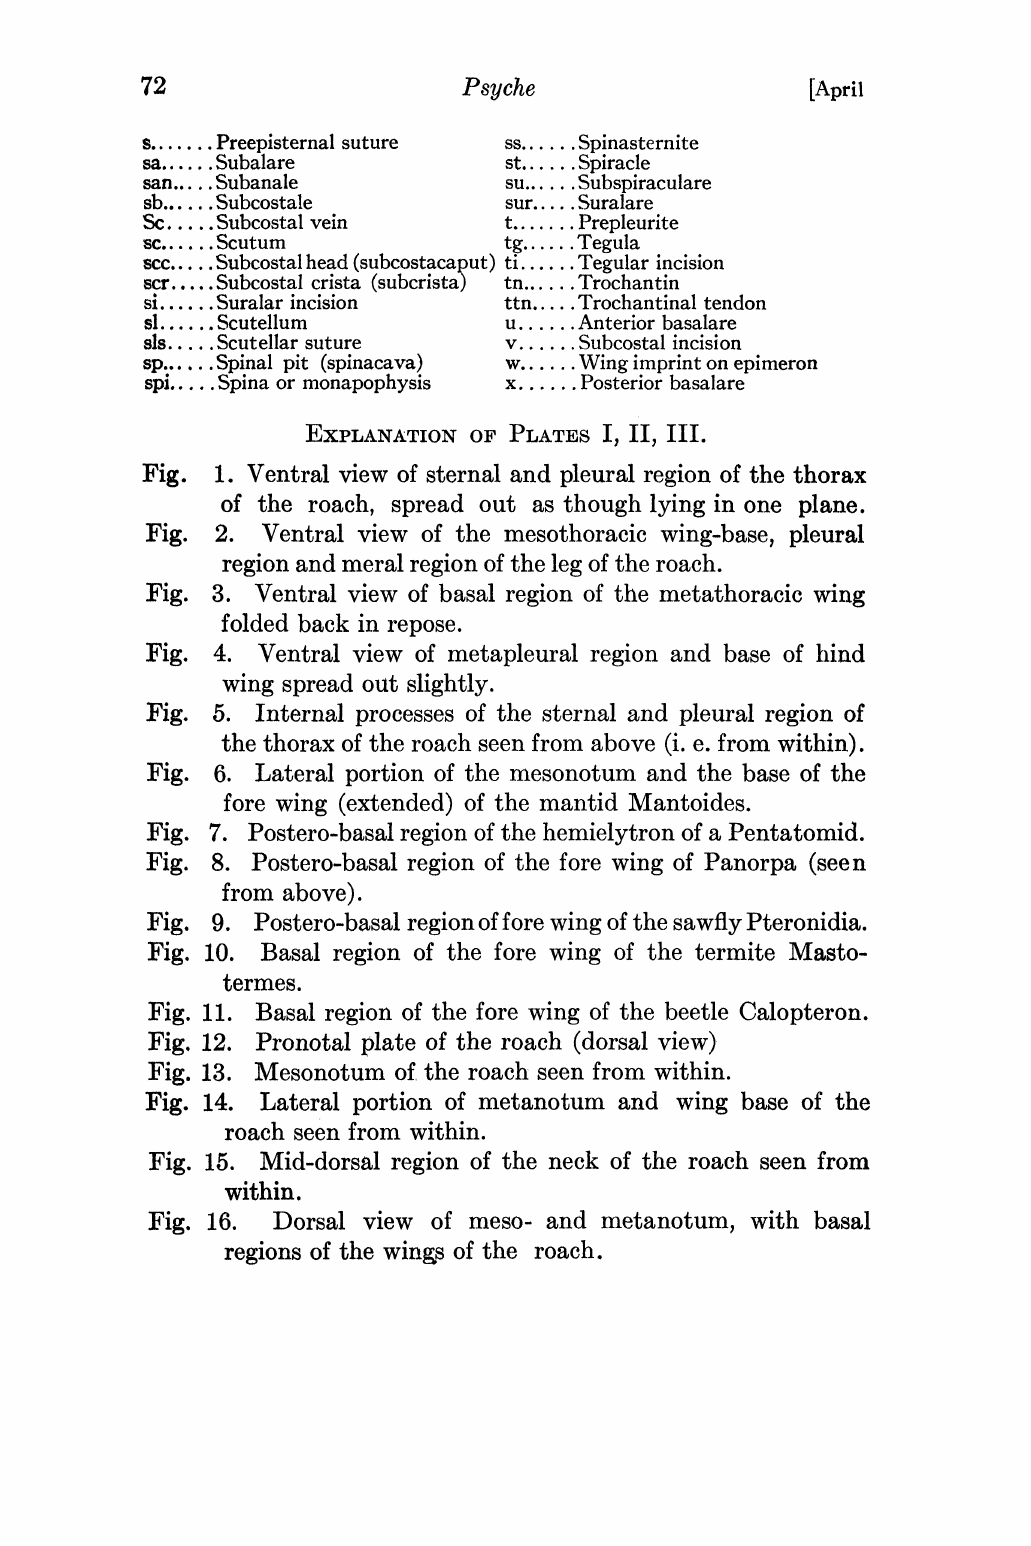
EXPLANATION OF PLATES I, II, III. 1. Ventral view of sternal and pleural region of the thorax of the roach, spread out as though lying in one plane. Fig. 2. Ventral view of the mesothoracic wing-base, pleural region and meral region of the leg of the roach. Fig. 3. Ventral view of basal region of the metathoracic wing folded back in repose. Fig. 4. Ventral view of metapleural region and base of hind wing spread out slightly. Fig. 5. Internal processes of the sternal and pleural region of the thorax of the roach seen from above (i. e. from within). Fig. 6. Lateral portion of the mesonotum and the base of the fore wing (extended) of the mantid Mantoides. Fig. 7. Postero-basal region of the hemielytron of a Pentatomid. Fig. 8. Postero-basal region of the fore wing of Panorpa (seen from above). Fig. 9. Postero-basal region offore wing of the sawfly Pteronidia. Fig. 10. Basal region of the fore wing of the termite Masto- termes. Fig. 11. Basal region of the fore wing of the beetle Calopteron. Fig. 12. Pronotal plate of the roach (dorsal view) Fig. 13. Mesonotum of. the roach seen from within. Fig. 14. Lateral portion of metanotum and wing base of the roach seen from within. Fig. 15. Mid-dorsal region of the neck of the roach seen from within. Fig. 16. Dorsal view of meso- and metanotum, with basal regions of the winks of the roach.